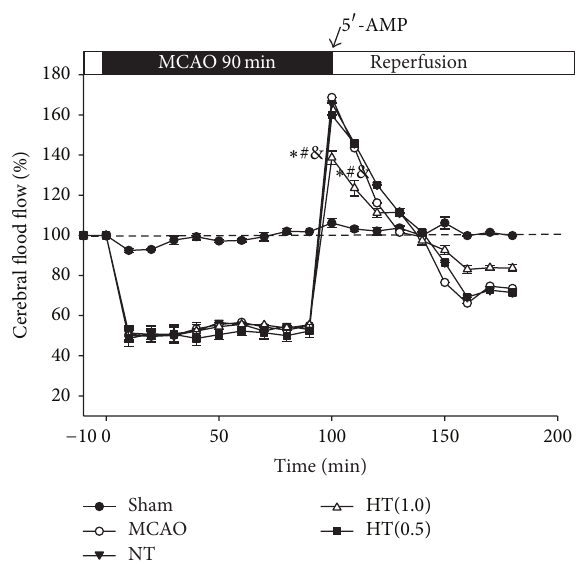
Figure 1: AIH reduces cerebral blood flow after ischemia/reperfu- sion in rats. The trend of CBF in the MCA area after ischemia and AIH was recorded using a laser Doppler flow meter. All values are mean ± SEM. ∗ 𝑃 < 0.05 compared to the MCAO group, # 𝑃 < 0.05 compared to the NT group, and & 𝑃 < 0.05 compared to the HT(0.5)